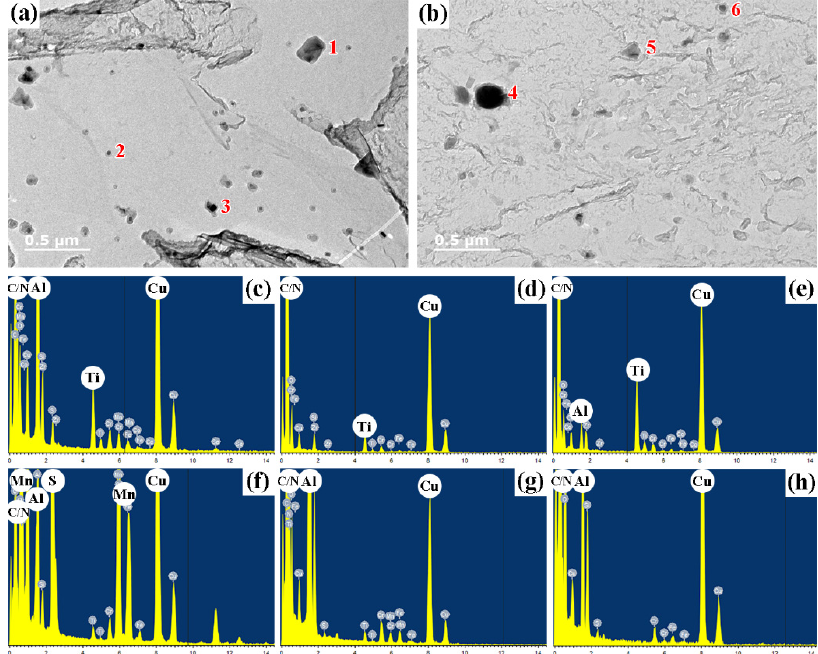
Figure 4. TEM micrograph of the precipitates after holding for 4 h at 977 °C of ( a ) S3 and ( b ) S4 and the corresponding EDS spectra of ( c – e ) particles 1–3 and ( f – h ) 4–6.